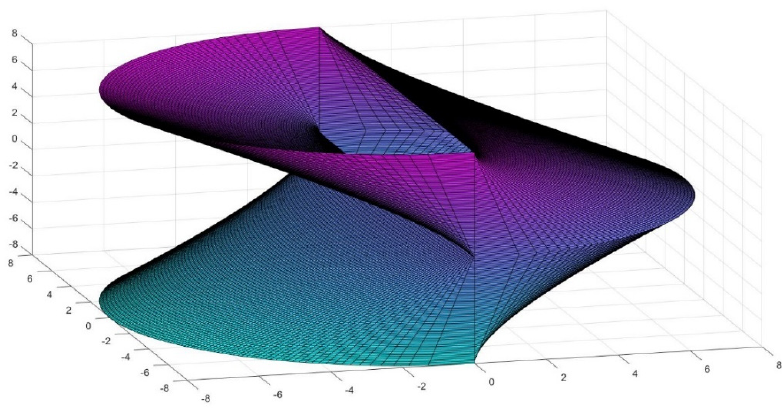
Figure 15. Initial Section of the Pterasphera.